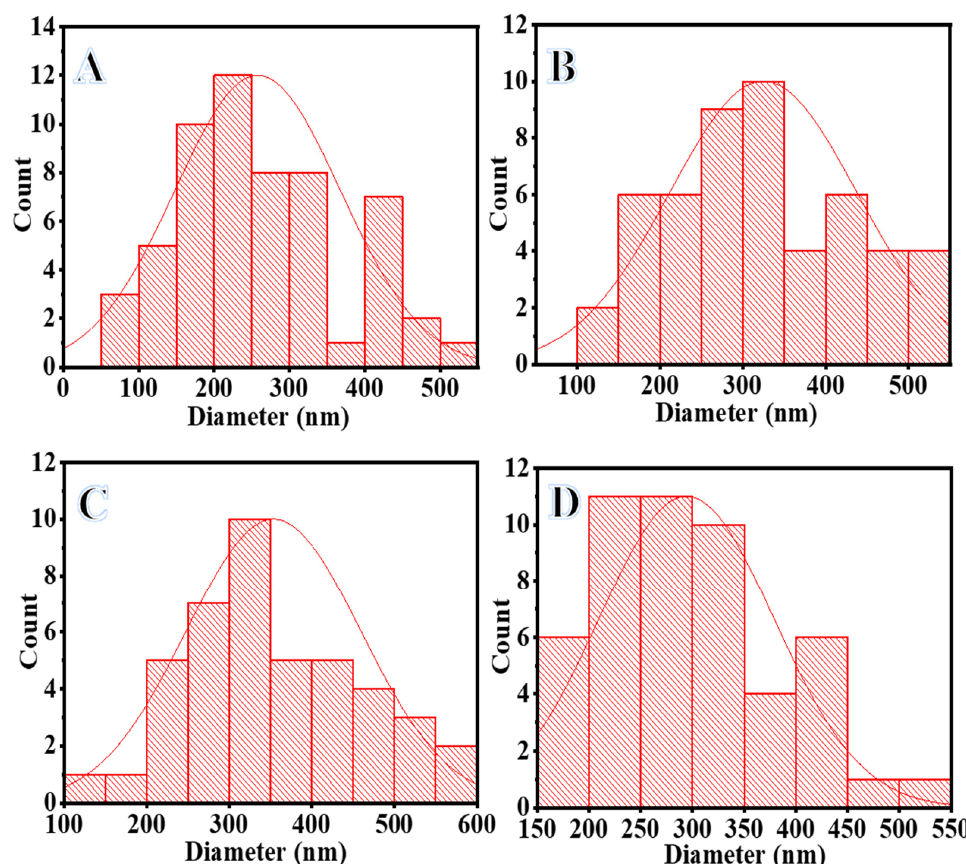
Figure 2. Size distribution of PVDF - co - HFP ( A ), Ni@PVDF - co - HFP ( B ), Ni 0.3 Co 0.7 @PVDF - co - HFP ( C ), and Co@PVDF - co - HFP ( D ).